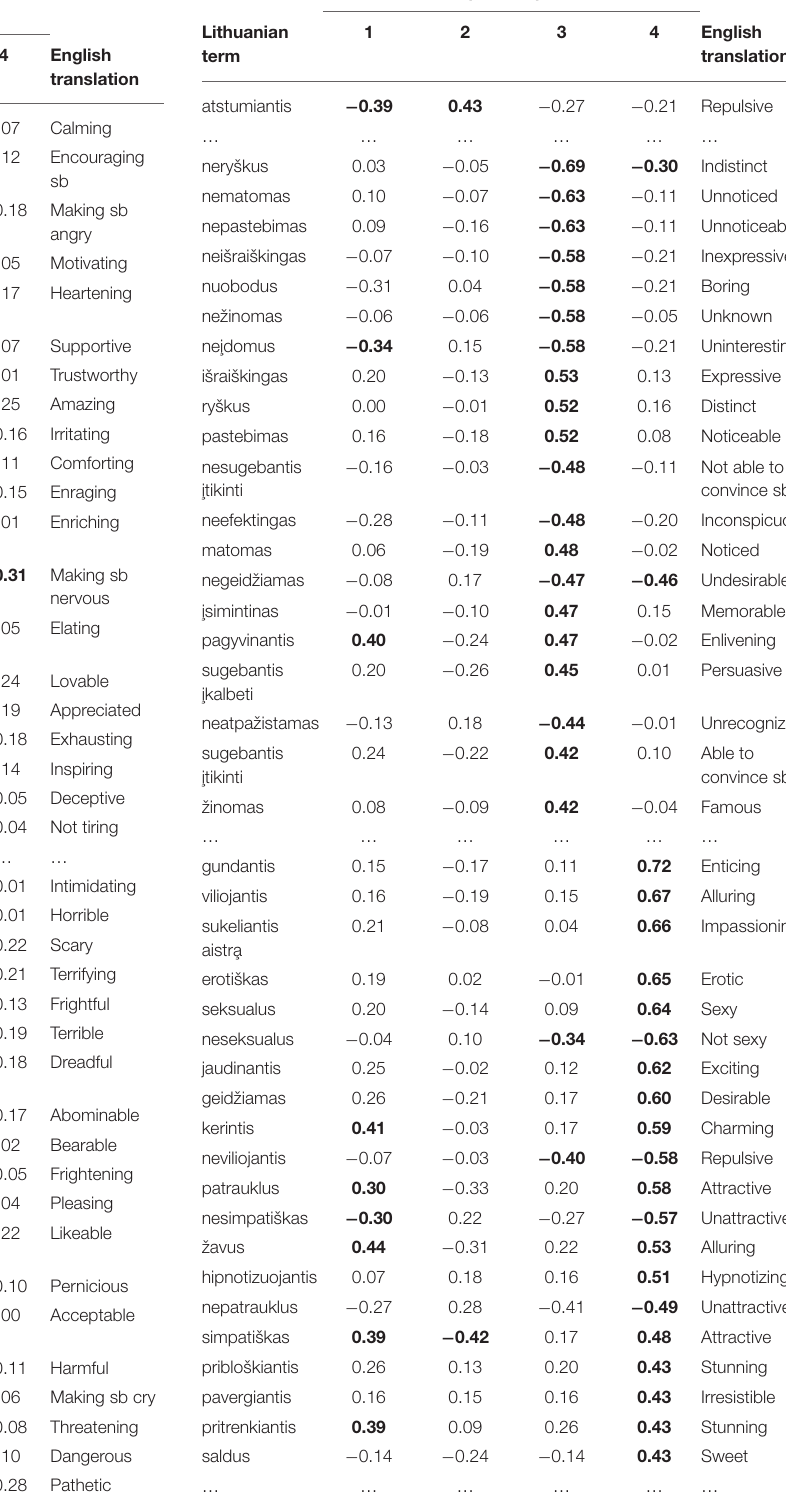
Loadings with absolute values of 0.3 or greater are given in bold